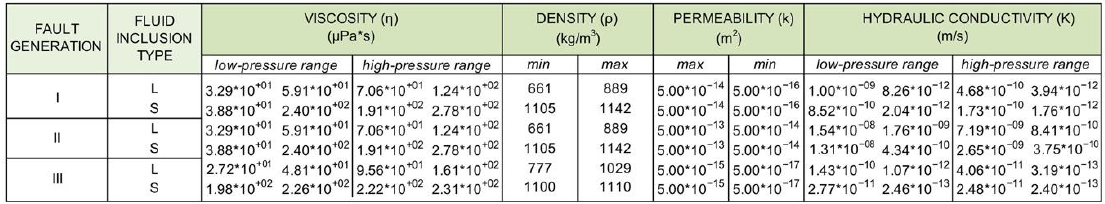
Figure 10. Minimum and maximum values of fluid viscosity and density, and of permeability and hydraulic conductivity for the different generation of fractures in the micaschist, as based on the parameters obtained by field and laboratory analyses. Symbols: L-liquid phase; S-solid phase (after Reference [12]). The asterisk indicates the multiplication sign.